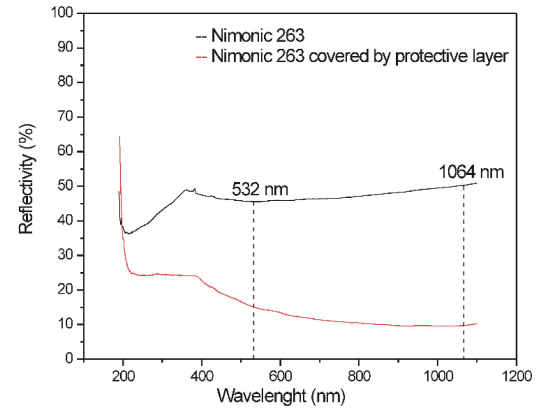
Figure 3. Comparative reflectance spectra of Nimonic 263 surface with and without protective paint layer.